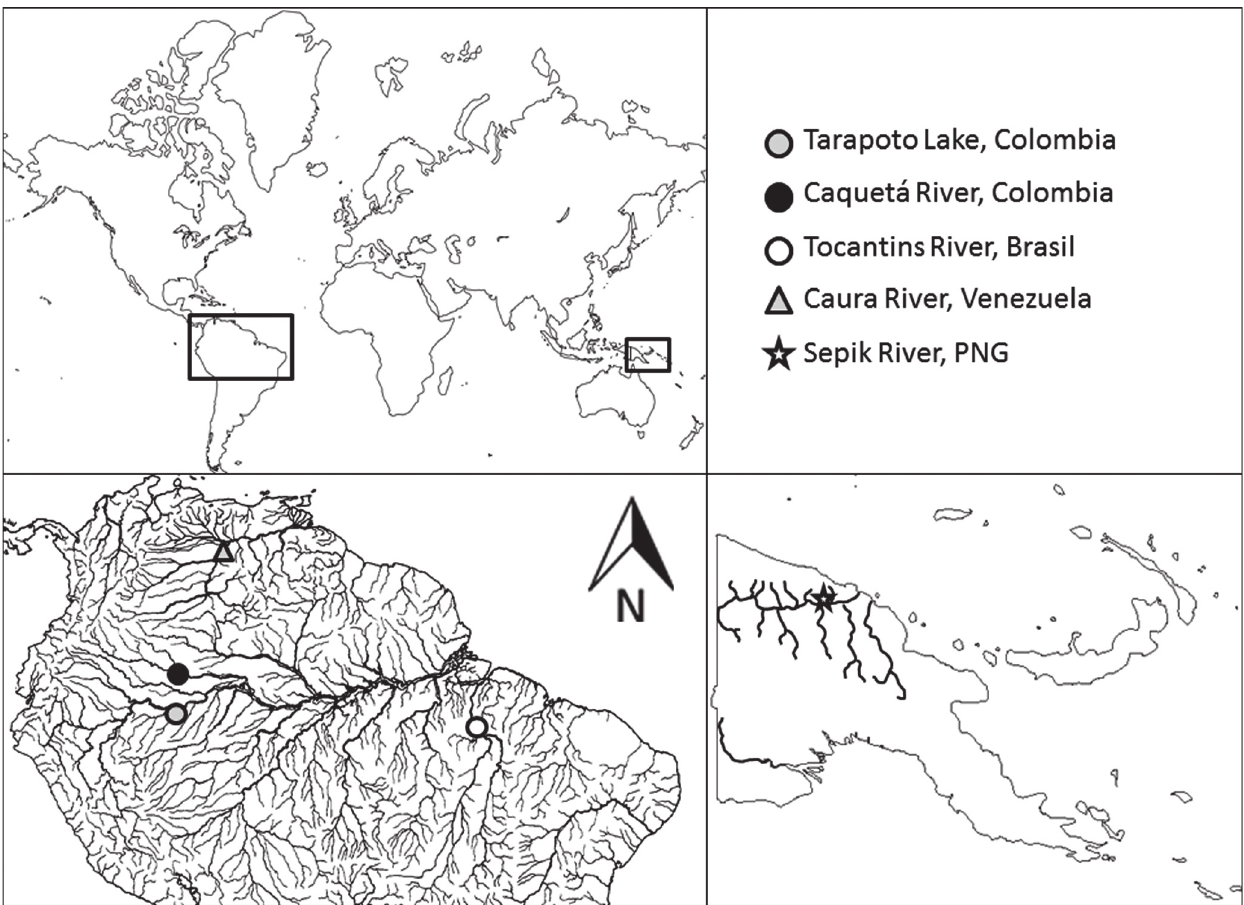
Fig. 1. Map of sampling site and locations of comparative studies. Circles represent sites in the Amazon Basin (Colombia: Tarapoto Lake and Caquetá River; Brazil: Tocantins River). The triangle represents a site in the Orinoco Basin (Venezuela: Caura River). The star represents the sampling site at the lower Sepik River, Papua New Guinea